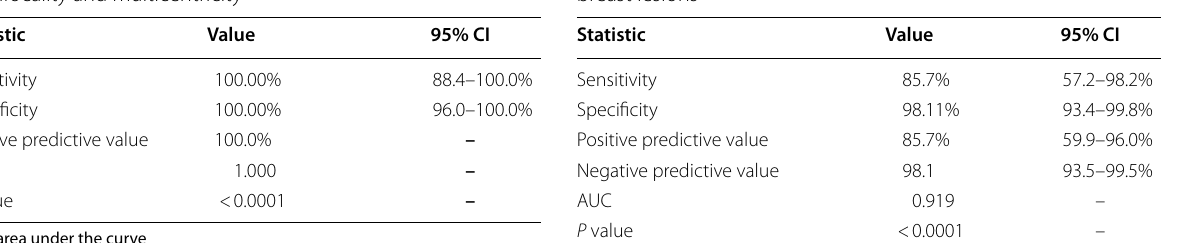
Table 4 Performance of MDCT chest in the detection of bilateral breast